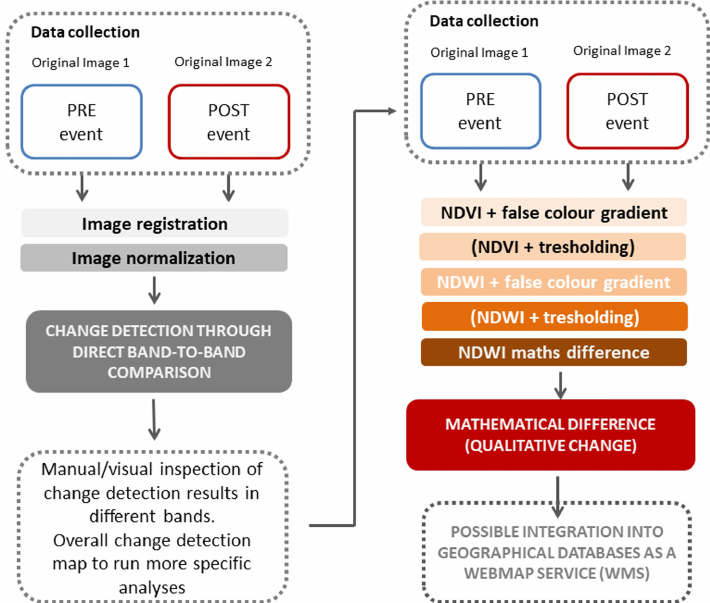
Figure 2. The overview of the workflow